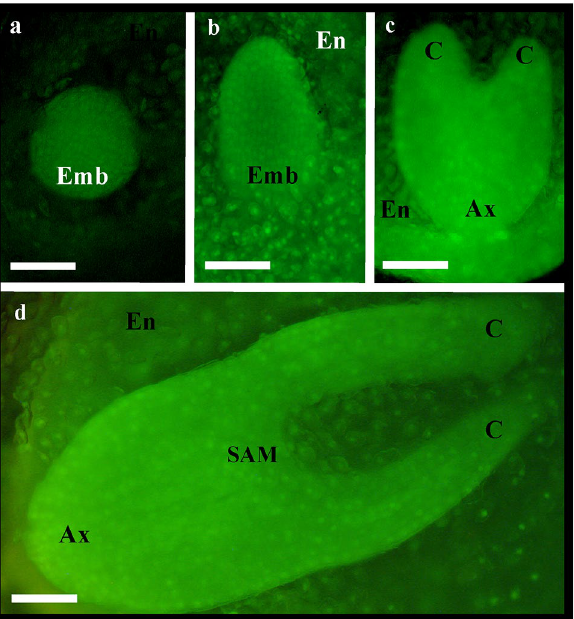
Figure 2. Globular ( a ), globular-heart transition ( b ), heart ( c ) and torpedo ( d ) of embryo developmental stages of Pulsatilla vernalis seeds noted under the fluorescence microscopy after staining with ethidium bromide and orange acridine. Scale bars = 100 µm. Ax, axis; C, cotyledon; Emb, embryo; En, endosperm; SAM, shoot apical